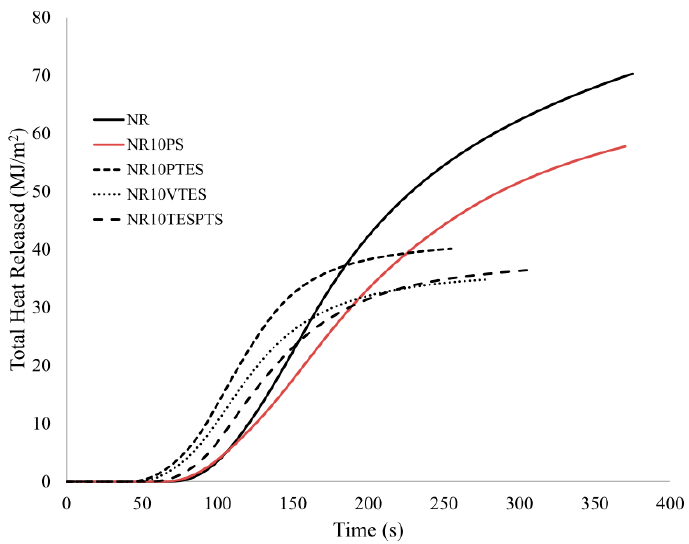
Figure 12. THR curves of NR rubber composites containing unmodified and modified natural filler.